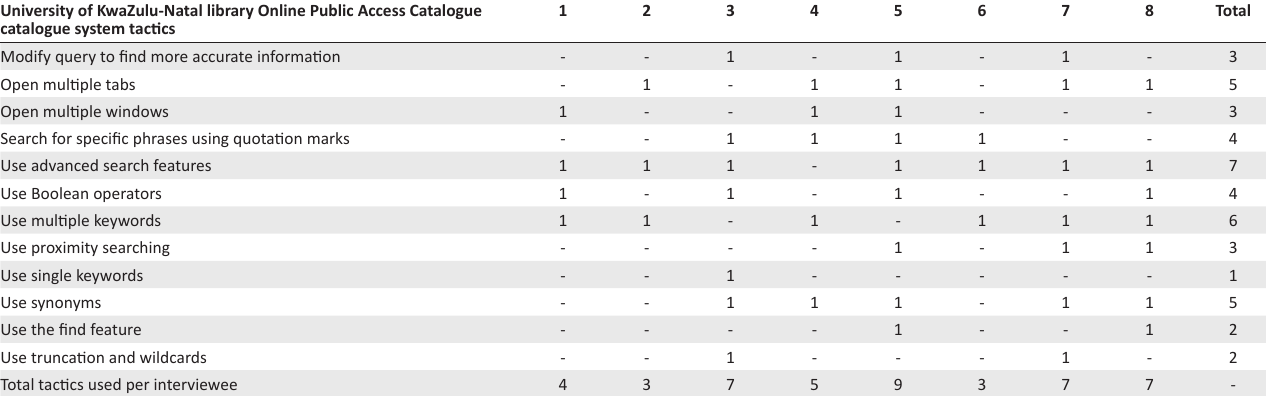
TABLE 5: Web search strategies using the University of KwaZulu-Natal library Online Public Access Catalogue